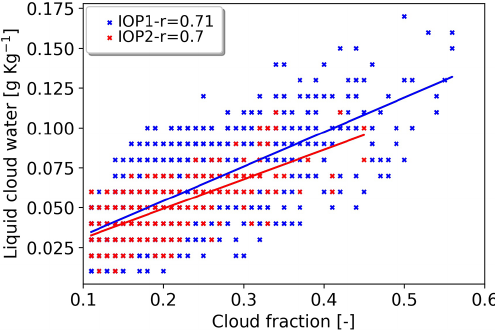
Figure 10. Scatter plot between the simulated cloud fraction and liquid cloud water content for the lower layer for cases selected dur- ing IOP1 (wet season – blue markers) and IOP2 (dry season – red